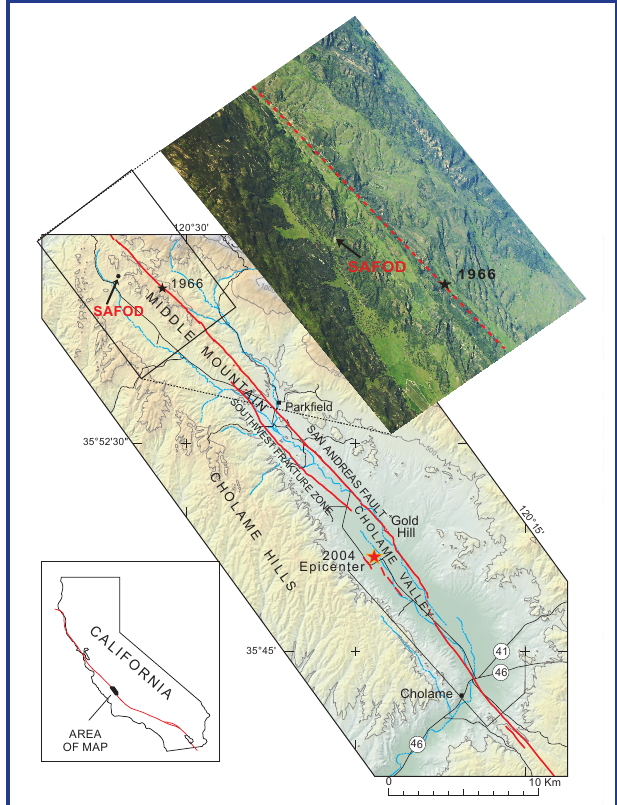
Figure 1. Map of the Parkfield segment of the San Andreas Fault showing the epicenters of the 1966 and 2004 Parkfield earthquakes and the SAFOD drillsite (Rymer et al., 2006). The air photo shows the terrain in the area of the SAFOD drill site and the epicenter of the 1966 Parkfield